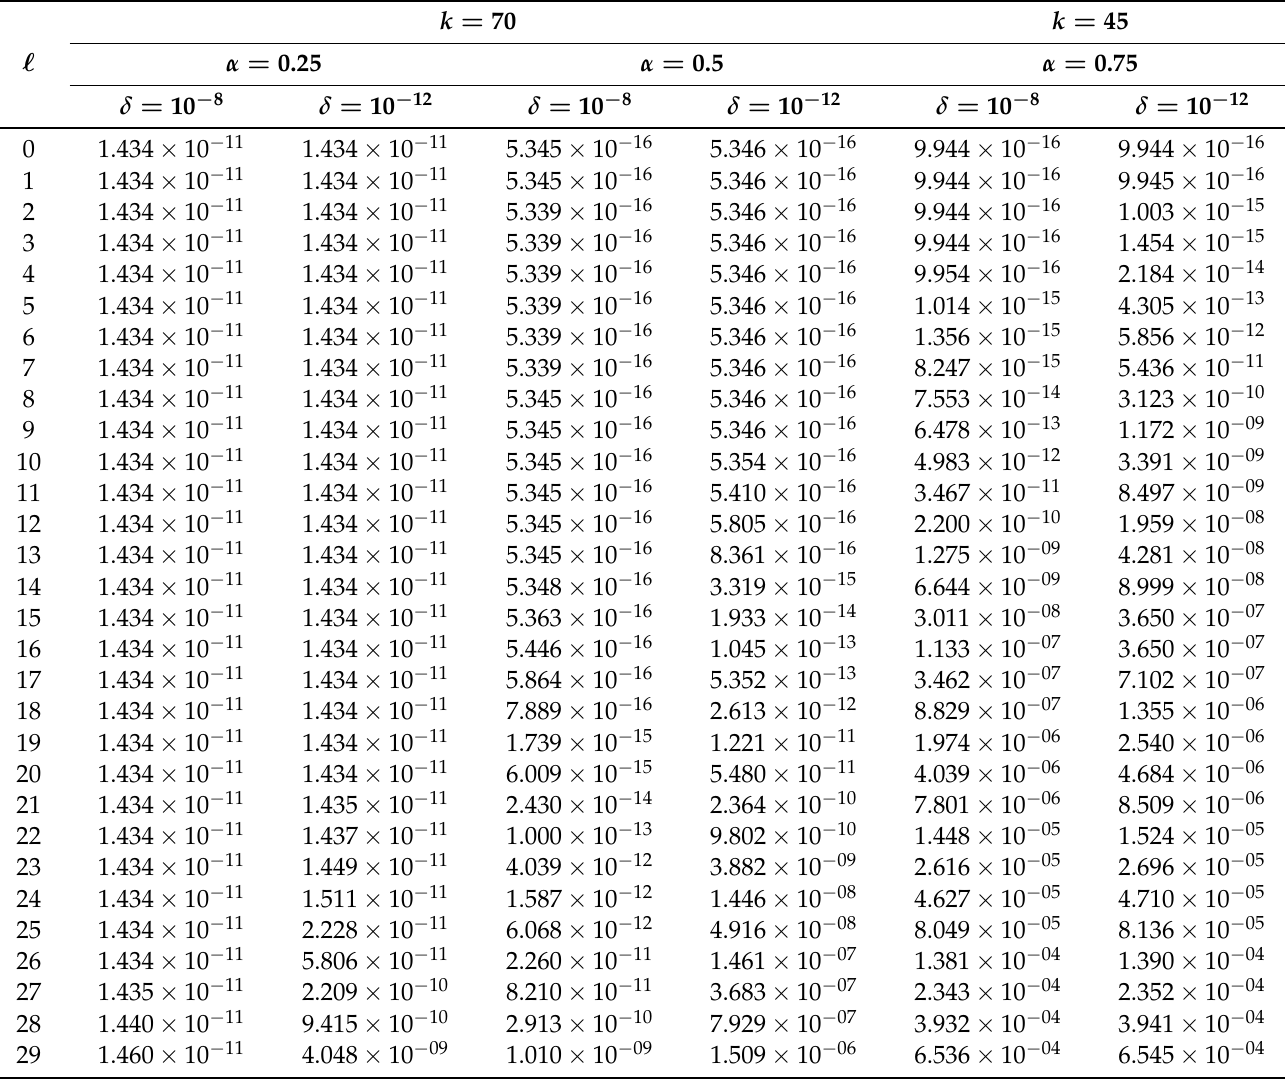
for α = α , k , (cid:96)